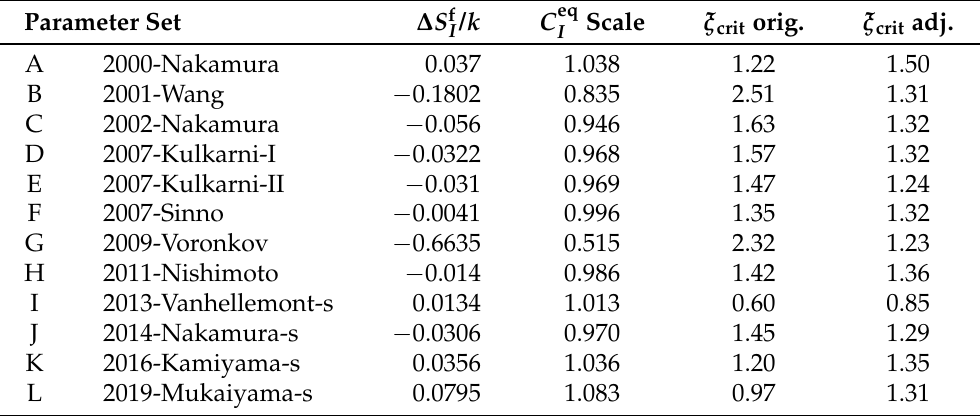
Table 4. Adjustment of C eq and the corresponding values of ξ crit (in 10 − 3 cm 2 min − 1 K − 1 ) at σ ave = I − 20MPa for original and adjusted PD